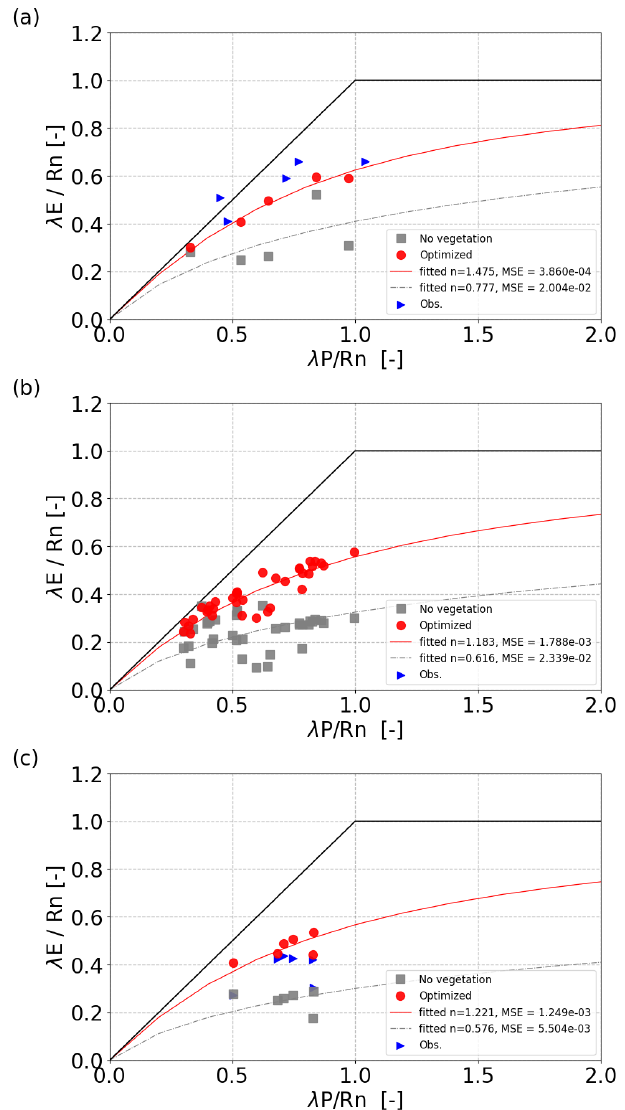
Figure 3. Results of the VOM in Budyko space for (a) flux tower sites along the North Australian Tropical Transect (NATT), (b) 36 additional points around the NATT, and (c) six catchments around the NATT. The VOM with fully optimized vegetation is shown in red dots, the VOM run without vegetation (bare soil) in gray squares, and observations (from flux tower data a or runoff data c ) in blue triangles. Lines are fits of Eq. (3) to the data points of the same